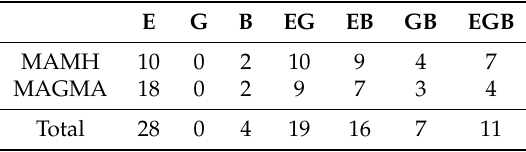
Table 2. Number of best results for each objective set.